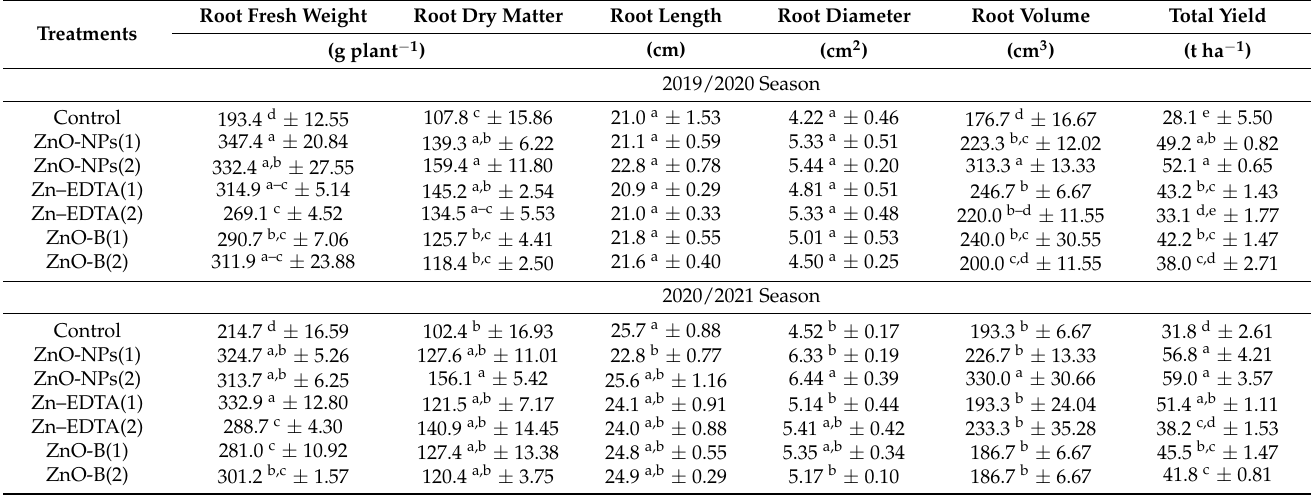
Table 7. Influence of foliar nourishment with some zinc (Zn) forms on yield and its components of carrot plants grown under Zn deficiency stress in two growth seasons.